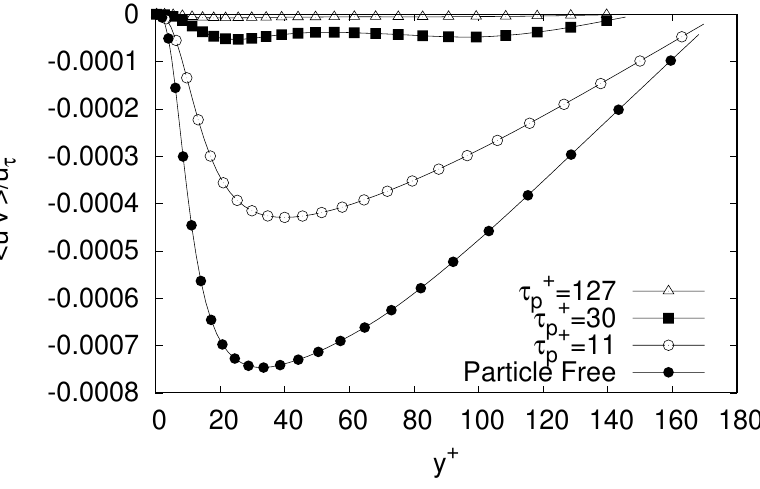
Figure 11. Comparison of < u (cid:48) v (cid:48) > profiles, for cases with Re τ = 180 and low, medium and high φ m . As evidenced in Figures 12–15 an attenuating effect of the turbulence over the carrier phase was also obtained for both A1 and A2 cases as a consequence of the presence of solid particles, consistent with previous results. However, in these cases, the highest levels of attenuation in the velocity fluctuations are attained for the case A 1. Moreover, it seems that the highest reduction of the velocity fluctuation intensities are presented in spanwise and wall-normal direction, respectively. Hence, the lower percentage of reduction observed in streamwise direction is presumably a consequence of a redistribution of the direction where momentum exchange is done on the carrier phase as consequence of solid particles. The solid particles tends to attenuate the velocity fluctuations intensities in all directions, although part of the attenuated energy in spanwise and wall-normal directions seems to be redistributed to the streamwise direction by the particles